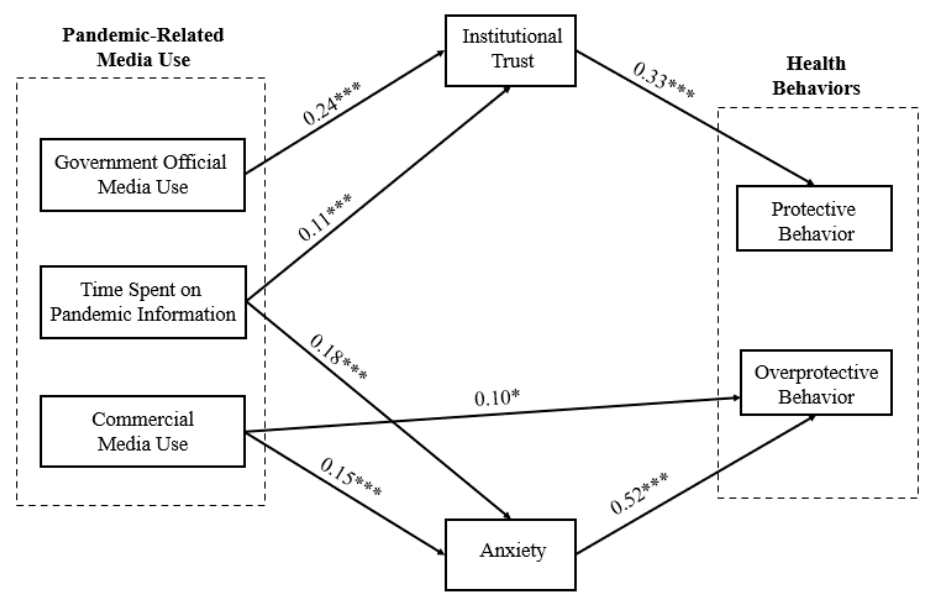
Figure 2. Structural equation modeling among pandemic-related media use, institutional trust, anxiety, protective behavior, and overprotective behavior ( *** p < 0.001, * p < 0.05 ) .